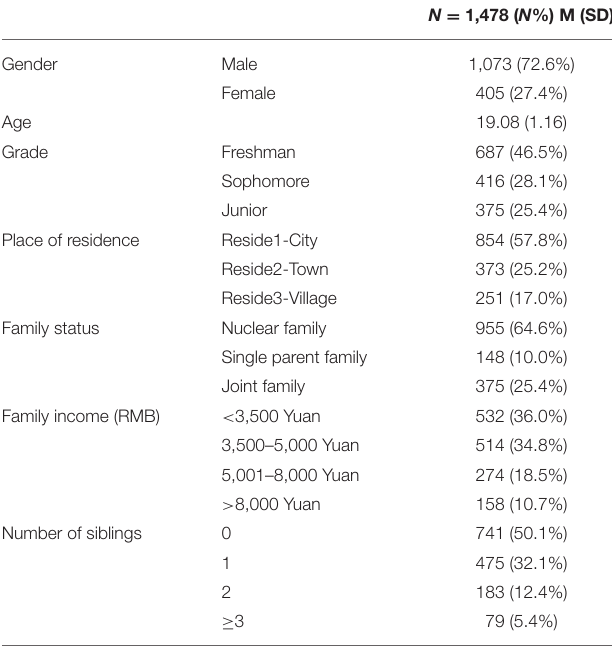
TABLE 1 | Demographic of medical students ( N =